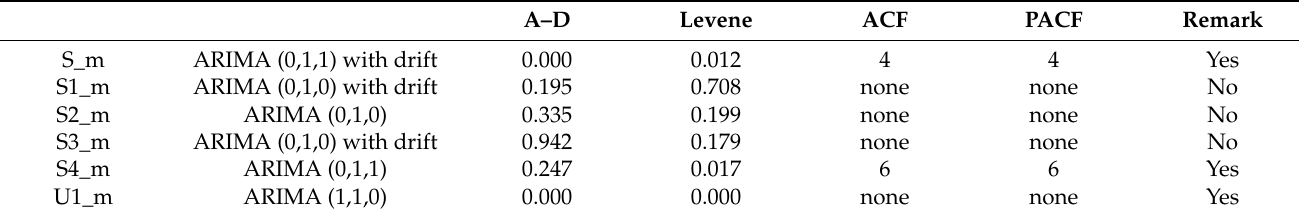
Table 17. Results of the statistical tests on the residual from ARIMA models for the monthly series. A–D ACF PACF